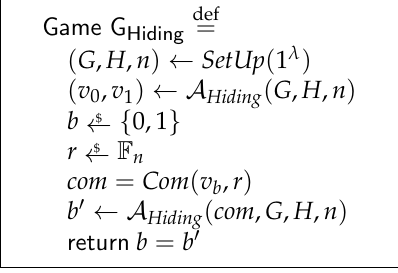
Figure 3. Game Hiding